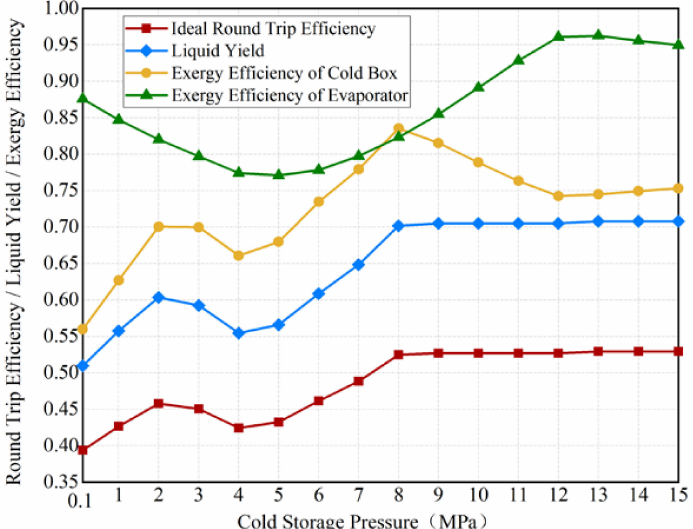
Figure 11. The effects of the cold storage pressure on the efficiencies of the LAES system.